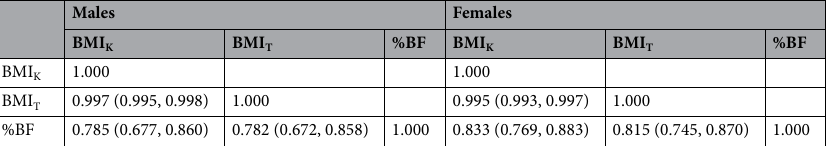
Table 3. Correlation matrix of anthropometric measures, stratified by sex (95% confidence intervals in parentheses). %BF body fat percentage, BMI T BMI calculated using the proposed modified (Trefethen) formula, BMI K BMI calculated using the Quetelet index popularized by keys.